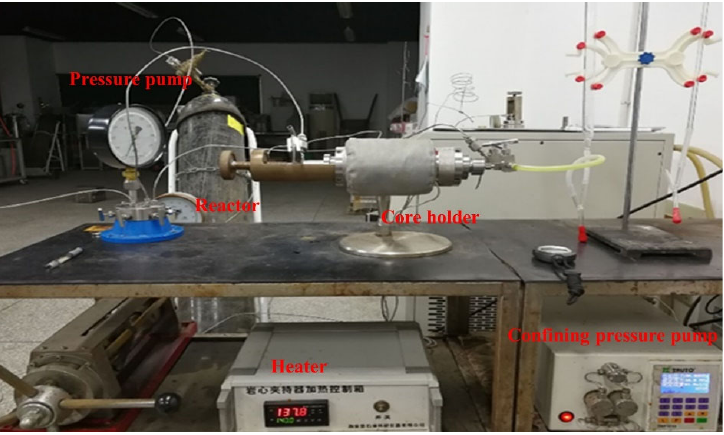
Figure 2. Experimental equipment used for water forced imbibition of water in shale.